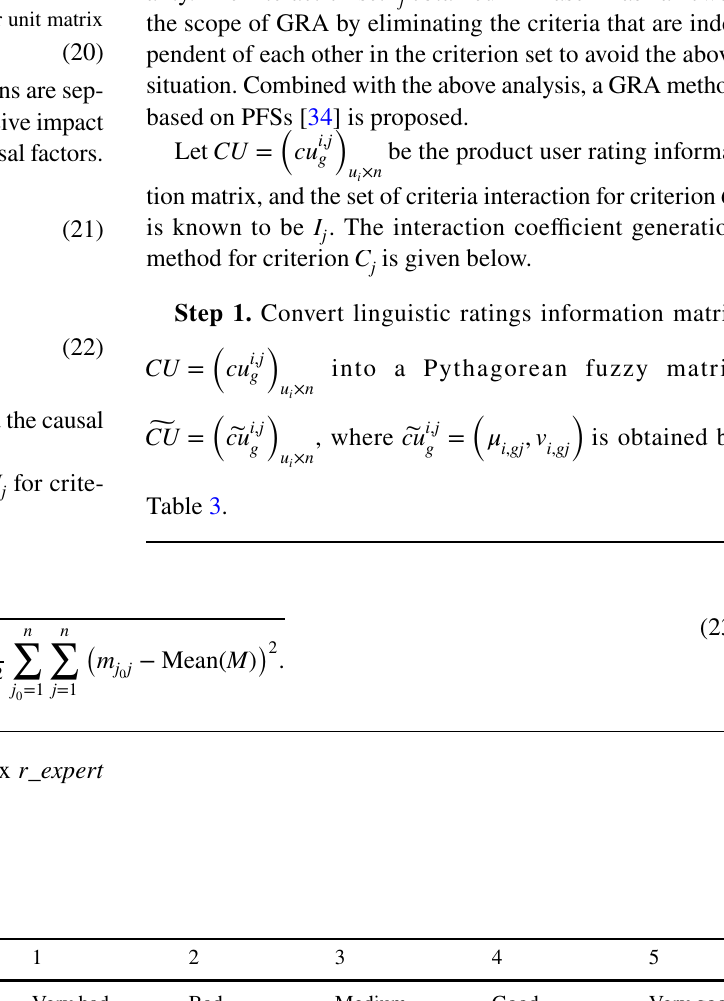
between linguistic linguistic ratings information and PFSs [32]